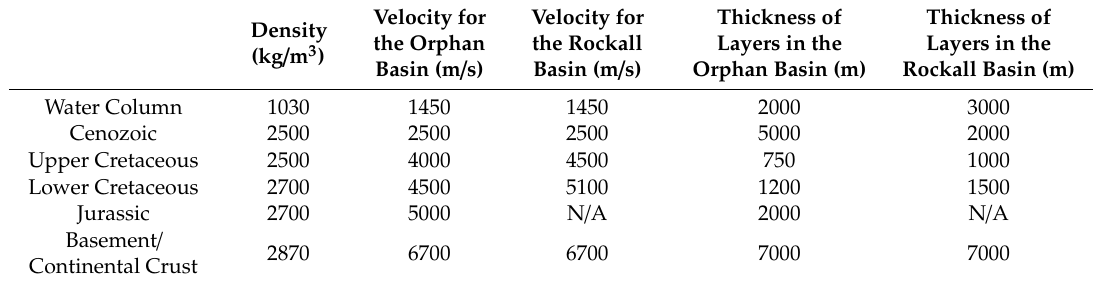
Table 1. Density parameters for each layer for both the Orphan and Rockall basins derived from seismic interval velocities [21]. Velocity parameters for each layer for the Orphan Basin interpreted from [3,21]. Velocity parameters for each layer from the Rockall Basin interpreted from [26,51]. Average present day thicknesses for each of the sequences in each of the basins are also provided from the depth conversion.